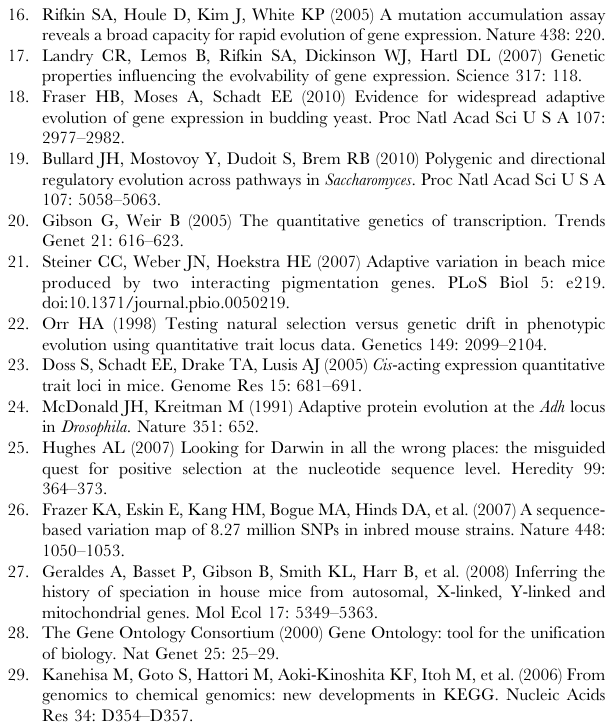
Table S1 Genes from Figure 2, and their GO annotations.